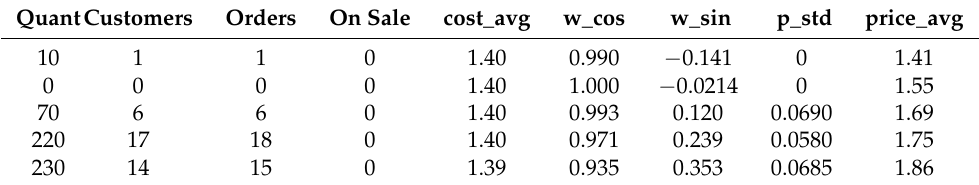
Table 4. A slice of the dataset used to generate input data for the NN models, for a given product. The columns contain the following information: quant is the number of units sold, customers is the number of different customers served, orders is the number of orders, on sale indicates how many orders had a price discount, avg_cost was the average cost of the product for the wholesaler, w _cos and w_sin are as defined in Equation (4), p_std is the standard deviation of the product prices, and price_avg is the weighted average of the product sale price. QuantCustomers Orders On